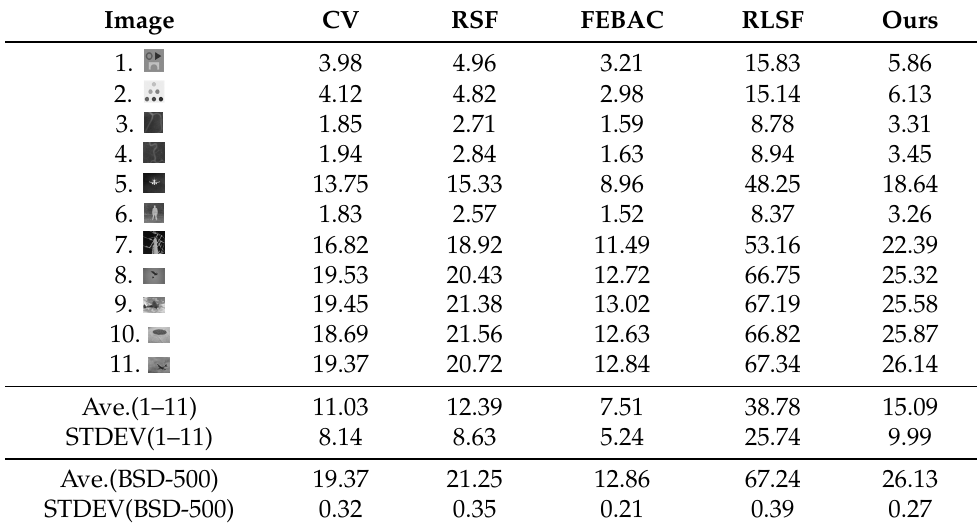
Table 2. The efficiency experiments with five methods on the 11 images and BSD-500 [41].